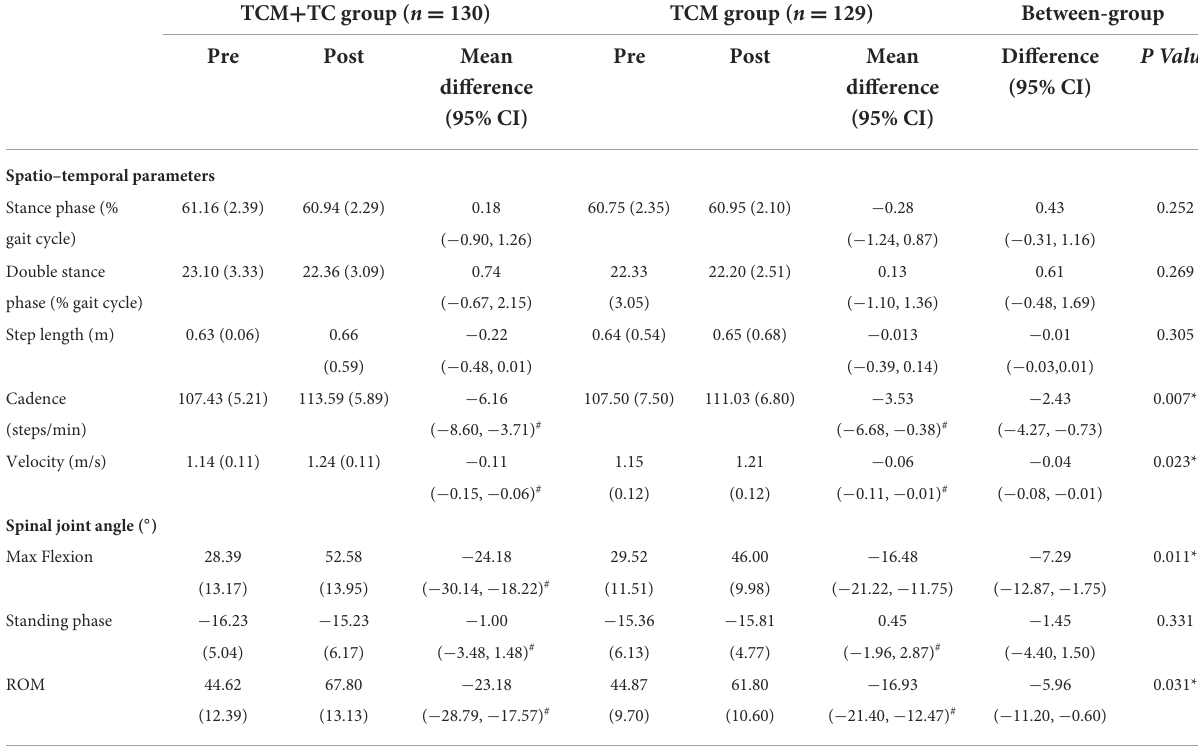
TABLE 6 Spatio-temporal and kinematic parameters of the study